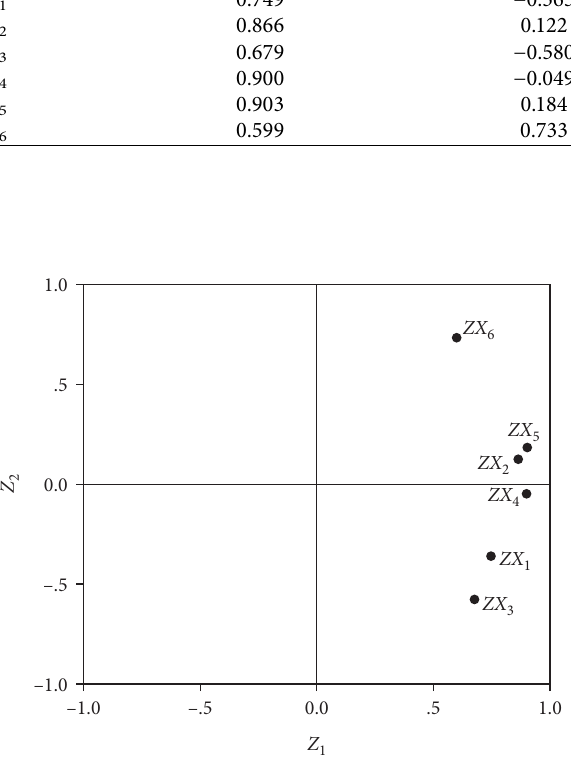
Figure 4: The coefficient between the content of 6 chromone compounds ( X 1 , X 2 , X 3 , X 4 , X 5 , and X 6 ) and Z 1 and Z 2